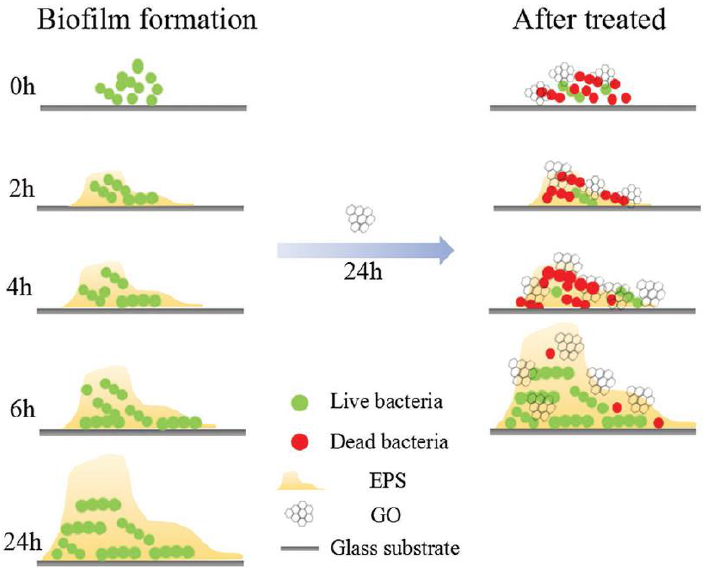
Figure 6. The prohibition effect of GO on biofilm formation. Reused with permission from [90]. Copyright © 2021 WILEY-VCH Verlag GmbH and Co. KGaA, Weinheim.